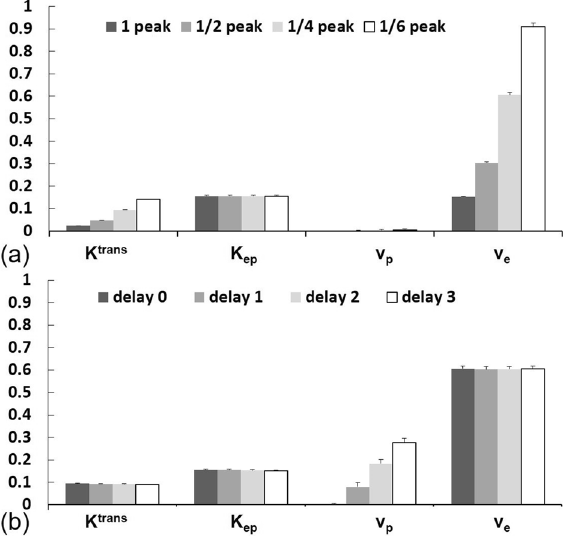
Figure 6. Perfusion parameters in a simulation study, varying ( a ) peaks and ( b ) delay times in the arterial input function.